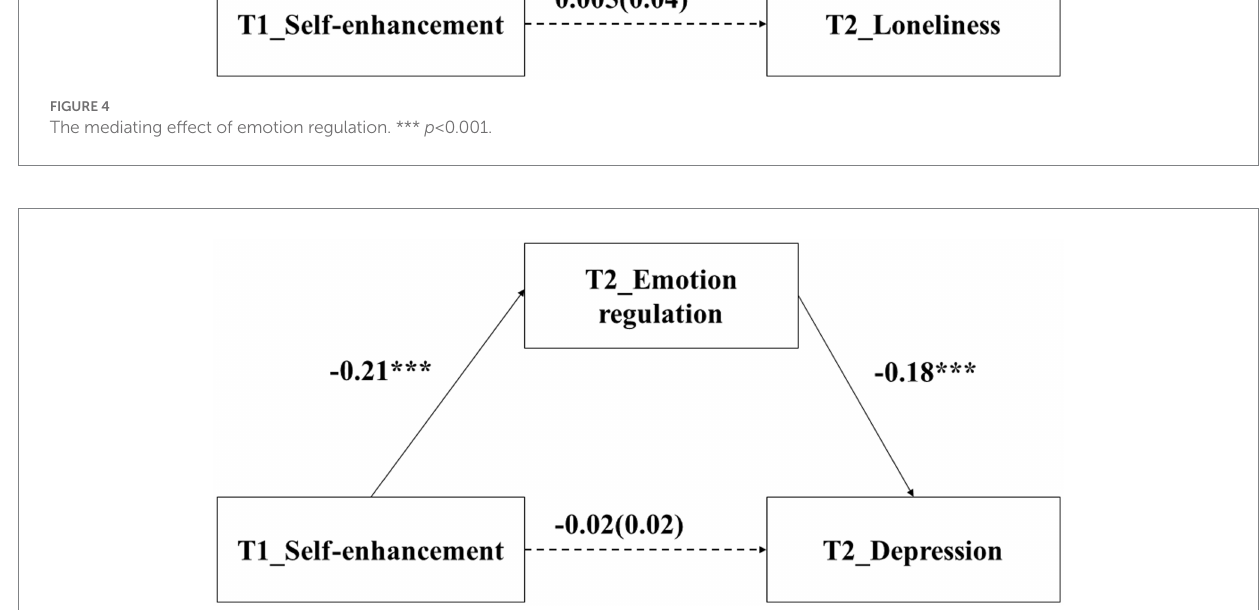
FIGURE 5 The mediating effect of emotion regulation. *** p <